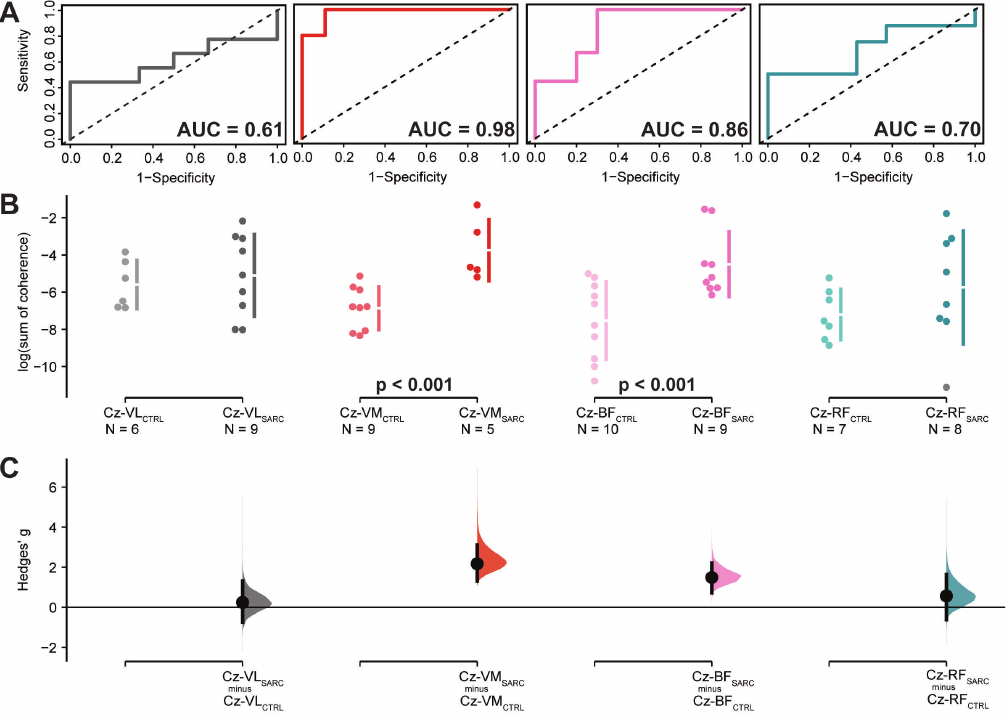
Figure 3. Results relative to the log-transformed coherence area (sum of coherence above significant confidence limits) between the EEG Cz sensor and the muscles located in the upper part of the lower limb: Vastus Lateralis (Cz-VL), Vastus Medialis (Cz-VM), Biceps Femoris (Cz-BF) and Rectus Femoris (Cz-RF). ( A ) shows the ROC curve with the respective accuracy (i.e., AUC estimate) depicted within the plot, precision (i.e., 1-specificity) shown on the x -axis while sensitivity presented in the y -axis. The dotted diagonal line depicts the 50% chance of di ff erentiating between sarcopenic and non-sarcopenic older adults. ( B ) Cumming estimation plots showing mean di ff erences of the log-transformed coherence area plotted in the upper axes separately for both sarcopenic (SARC, darkish color) and healthy control older adults (CTRL, light color). Each mean di ff erence is represented by dots and plotted on the ( C ) lower axes as a bootstrap sampling distribution, while the ends of the vertical error bars denote the 95% confidence